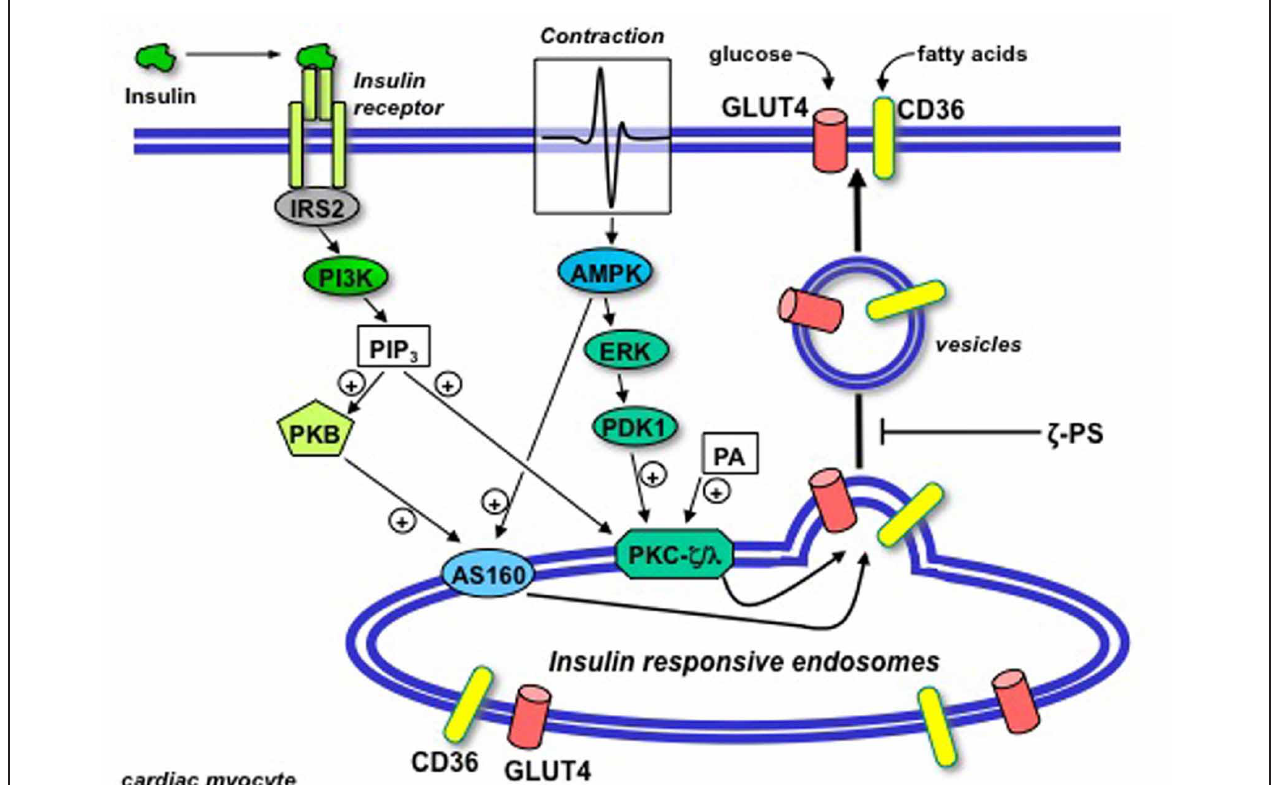
FIGURE 4 | Schematic presentation of the putative permissive role of atypical protein kinase C (isoforms ζ / λ ) in GLUT4 and CD36 translocation in the heart. Upon binding to its receptor at the cell surface, insulin sequentially activates insulin-receptor substrate 2 (IRS2) and PI3K, resulting in the production of PIP 3 . Beyond PI3K, the insulin signal is split into two parallel branches. PIP 3 binds to both Akt/PKB and PKC- ζ / λ . In case of Akt/PKB this results in the activation and subsequent phosphorylation of AS160. In case of PKC- ζ / λ this does not result in further activation because the basally high levels of phosphatidic acid (PA) in the heart impose PKC- ζ / λ to be already bound to endosomal membranes in the absence of insulin